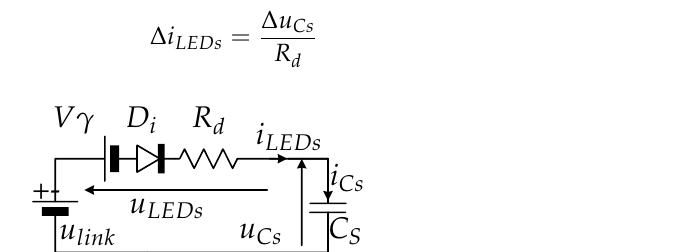
Figure 5. Subcircuit for HF LED ripple calculation, in Mode II. ( Q A switched off, Q B switched